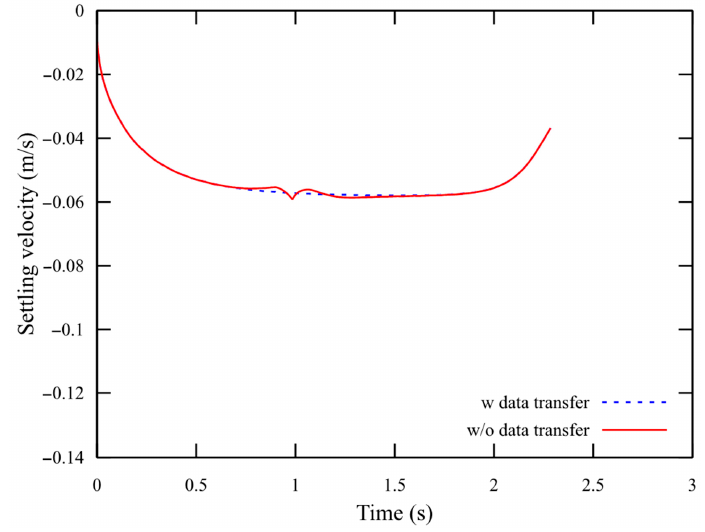
Figure 3. Data transfer between processors.